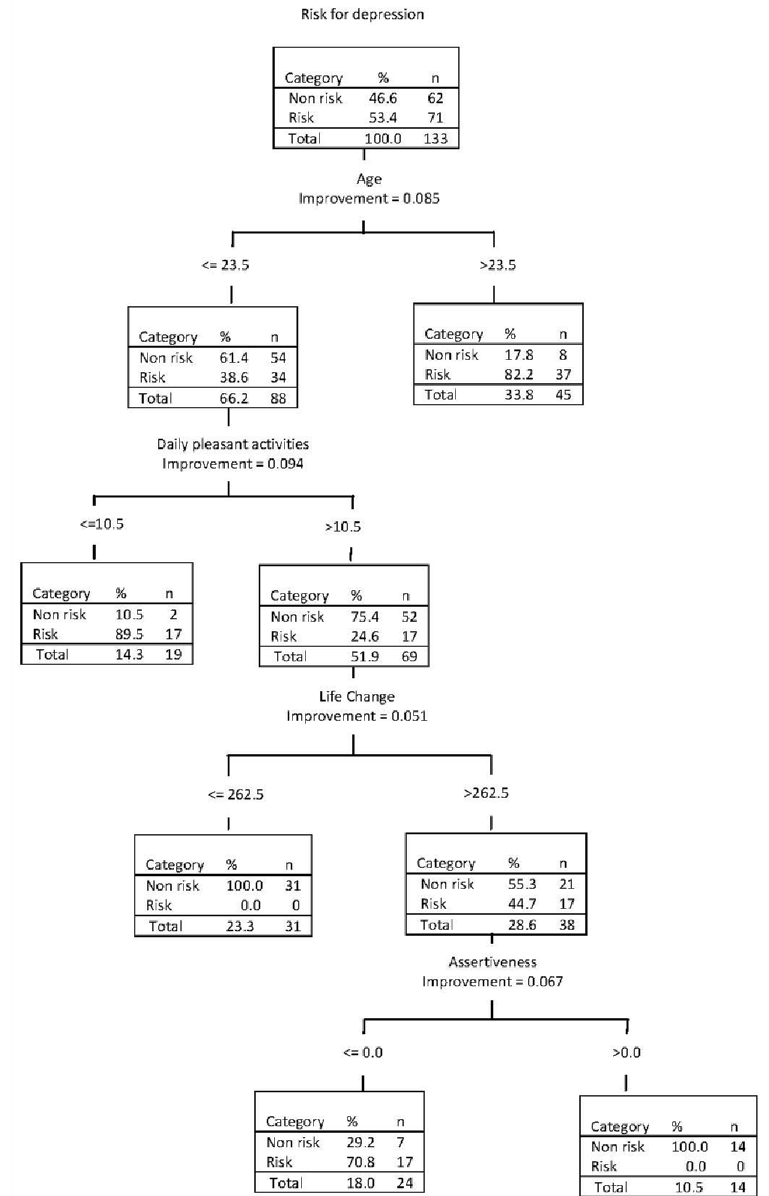
Figure 1. CTA decision rules predicting risk of persistent depression with pretest variables and prevention conditions by 6 month